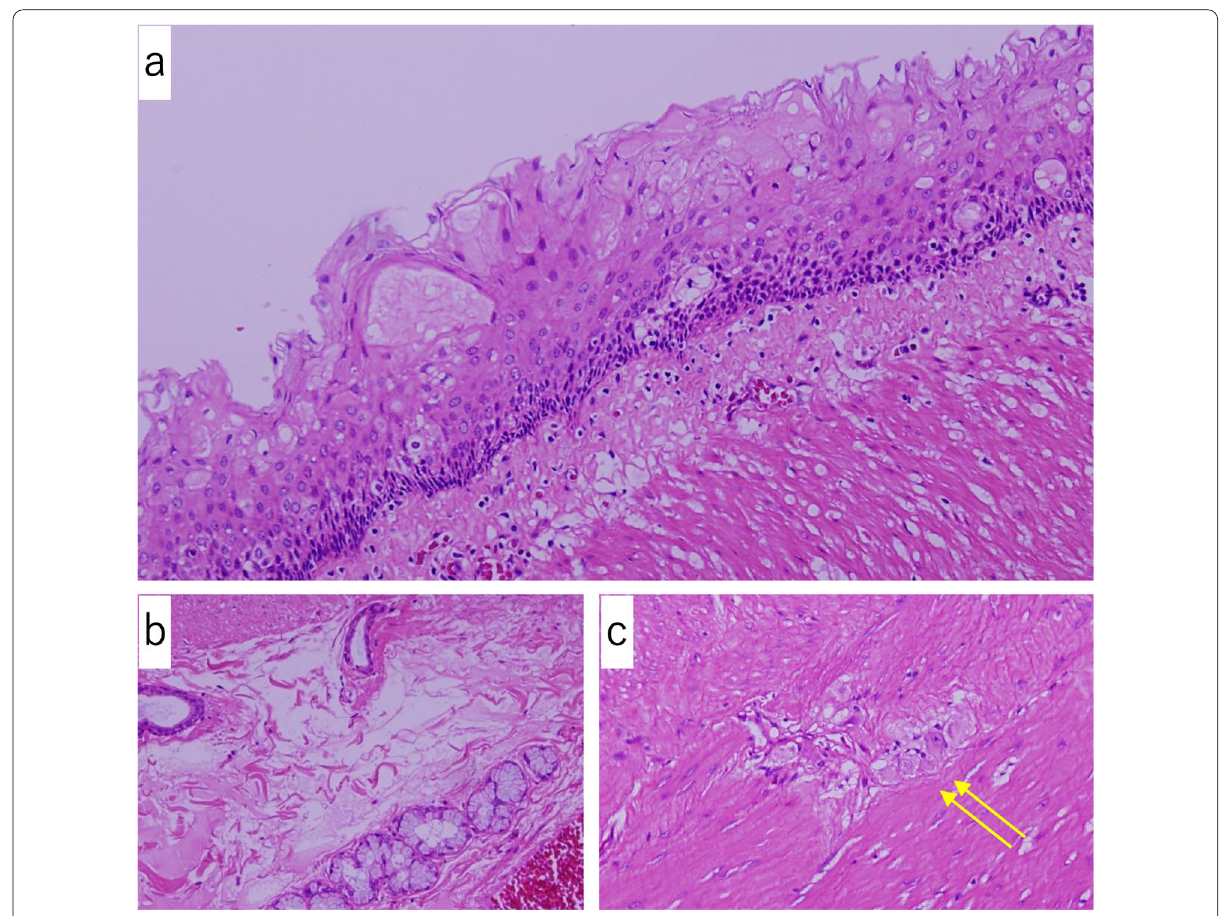
Fig. 5 Histopathological findings. The cystic epithelium appears as stratified squamous epithelium (hematoxylin–eosin [HE], esophageal glands are observed in the submucosa, which has mucous glands and ducts (HE, structure with inner circular and outer longitudinal muscle layers ( c ). In addition, nerves and ganglion cells (Auerbach plexus, yellow arrow) are found between the two layers (HE, ×